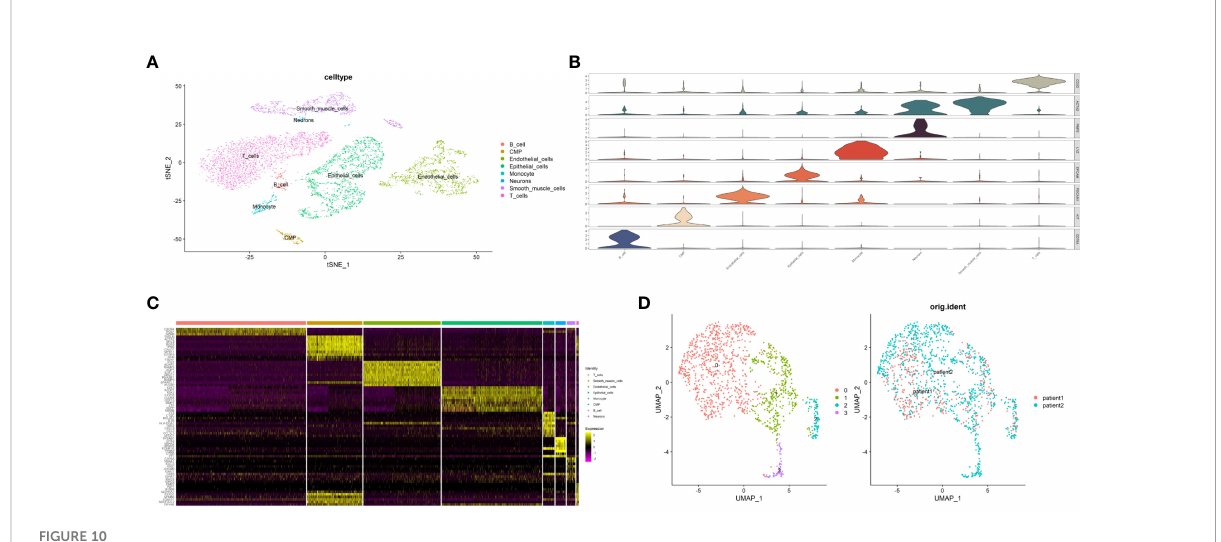
FIGURE 10 Identi fi cation of malignant epithalial cells and subgroups of two PCa patients at single-cell level. (A) The t-distributed stochastic neighbor embedding (t-SNE) plot clustering all cells into different clusters. Each dot represents a cell and colored according to its celltype. (B) Violin plot demonstrates the accuracy of cell annotation by showing speci fi c markers. (C) Heatmap shows the top10 differential expressed genes of each cell type (ordered by average log2|fold change|). (D) The uniform manifold approximation and projection (UMAP) plot clustering all malignant epithalial cells into 4